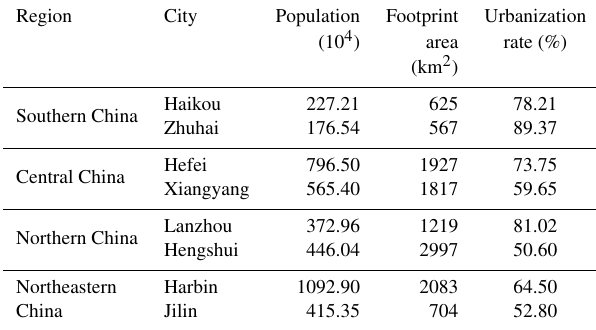
Table 1. Statistics of the